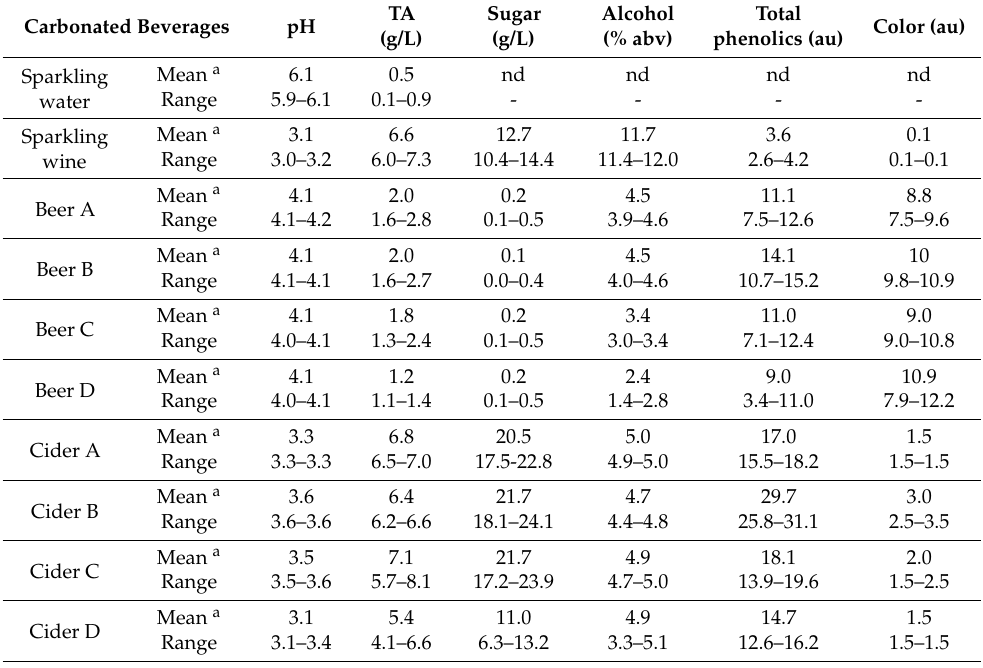
Table 1. pH, titratable acidity, sugar, alcohol content, total phenolics, and color of the carbonated beverages after sonication and refrigeration or